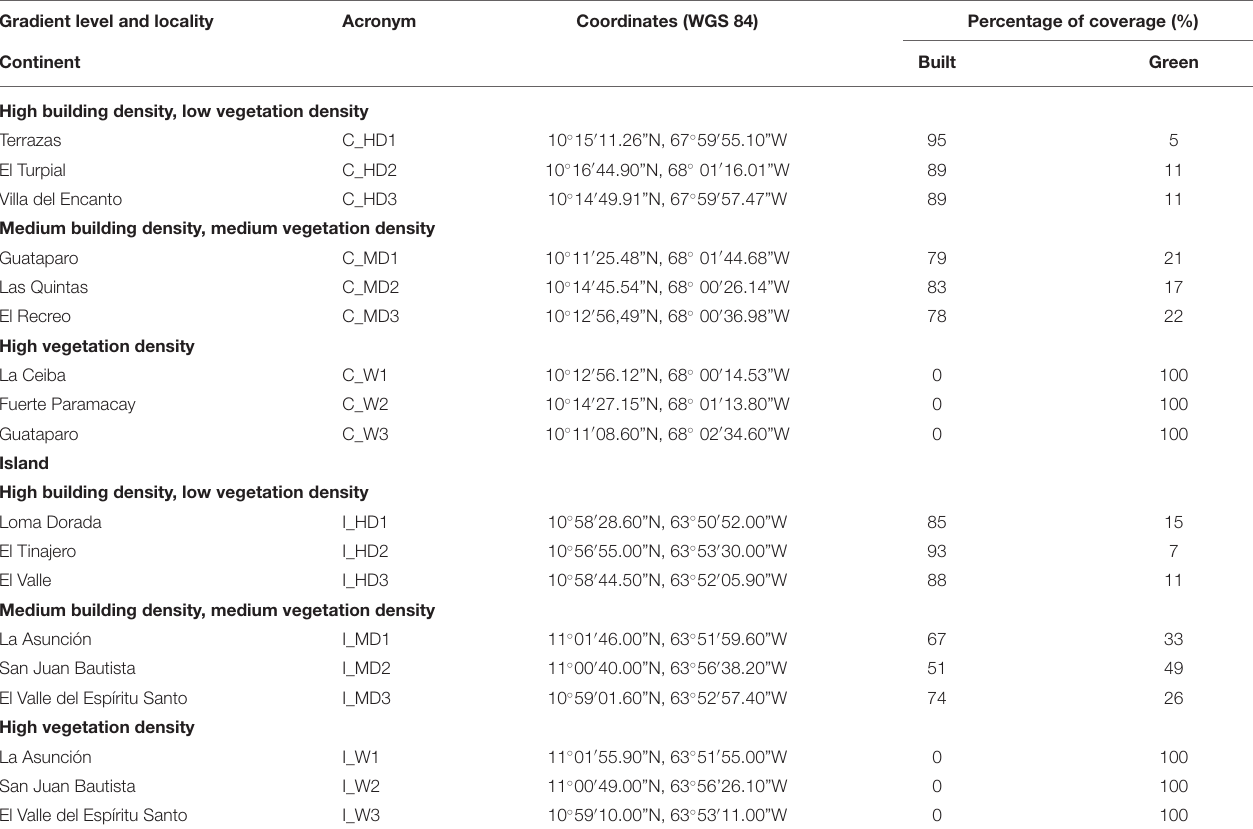
TABLE 1 | Location, acronyms, and relative coverage of built and paved, as well as vegetation surface of the 18 sampling units selected along the urban gradient of Continent and Island. Gradient level and